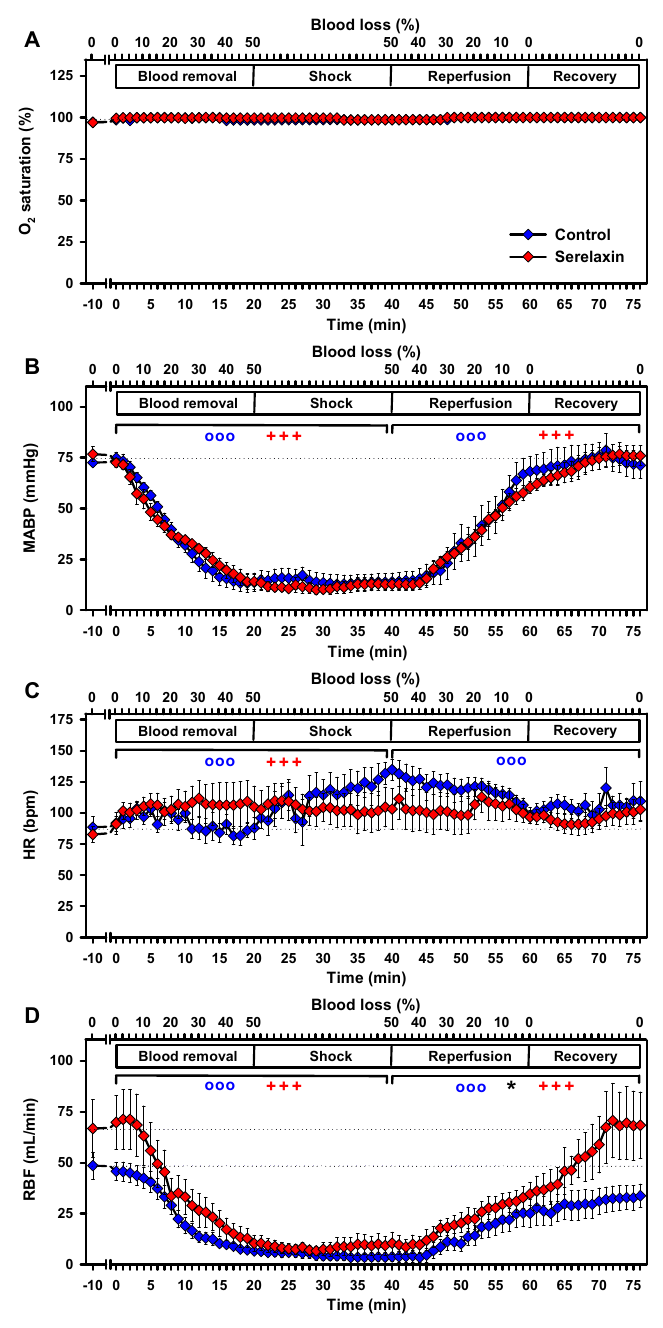
Figure 5. Effects of controlled hemorrhage with a resulting shock period and reperfusion on vital parameters. ( A ) oxygen saturation (O 2 saturation), ( B ) MABP, ( C ) HR and ( D ) RBF. Linear mixed models were separately calculated for hypoxia and reoxygenation versus baseline values. ooo, p < 0.001 for the comparison of the control group with baseline values. +++ p < 0.001 for the comparison of the serelaxin-treated group with baseline values. * p < 0.05 for the comparison between the two experimental groups. Dotted lines indicate baseline values.